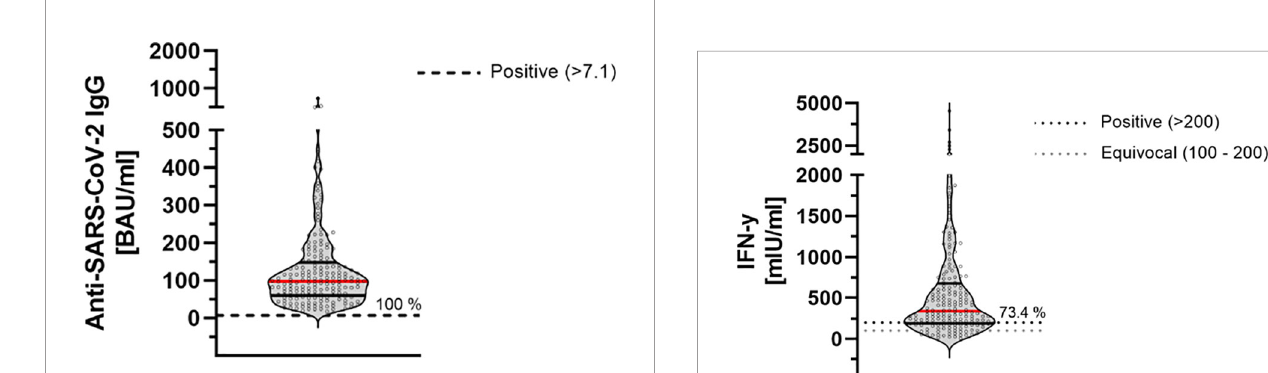
FIGURE 4 | T-cell-response assessed by measuring IFN-gamma release 9 months after second dose of BNT162b2. Cellular immunity to SARS-CoV-2 was assessed by using an Interferon (IFN)-gamma release assay (IGRA) from Euroimmun (Quan-T-cell SARS-CoV-2 kit). Values > 200 mIU/ml were considered positive (horizontal black dotted line), whereas values between 100-200 mIU/ml were considered equivocal (horizontal gray dotted line). Red line marks the mean. The dashed lines show the positive (light gray)- and equivocal (dark gray) cutoffs speci fi ed by the